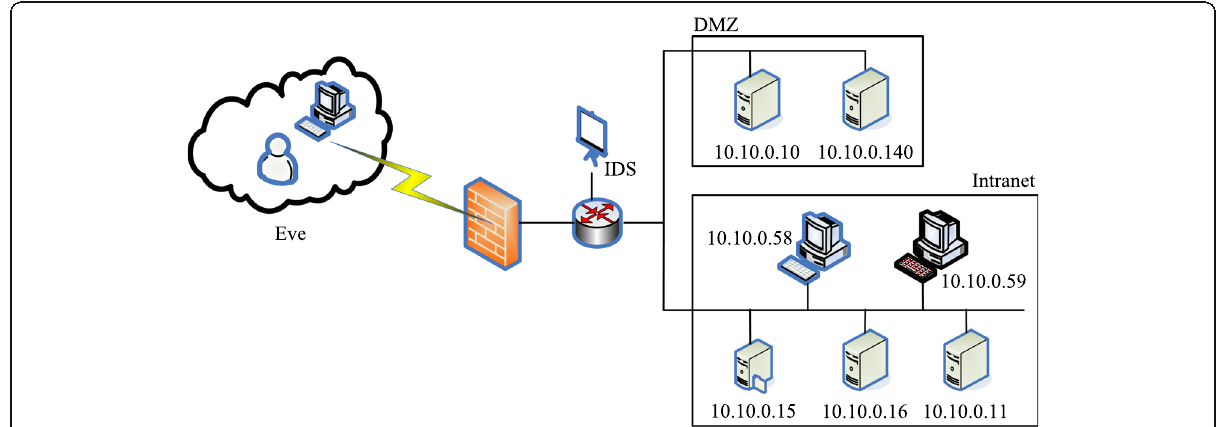
Fig. 2 The graph of experimental network